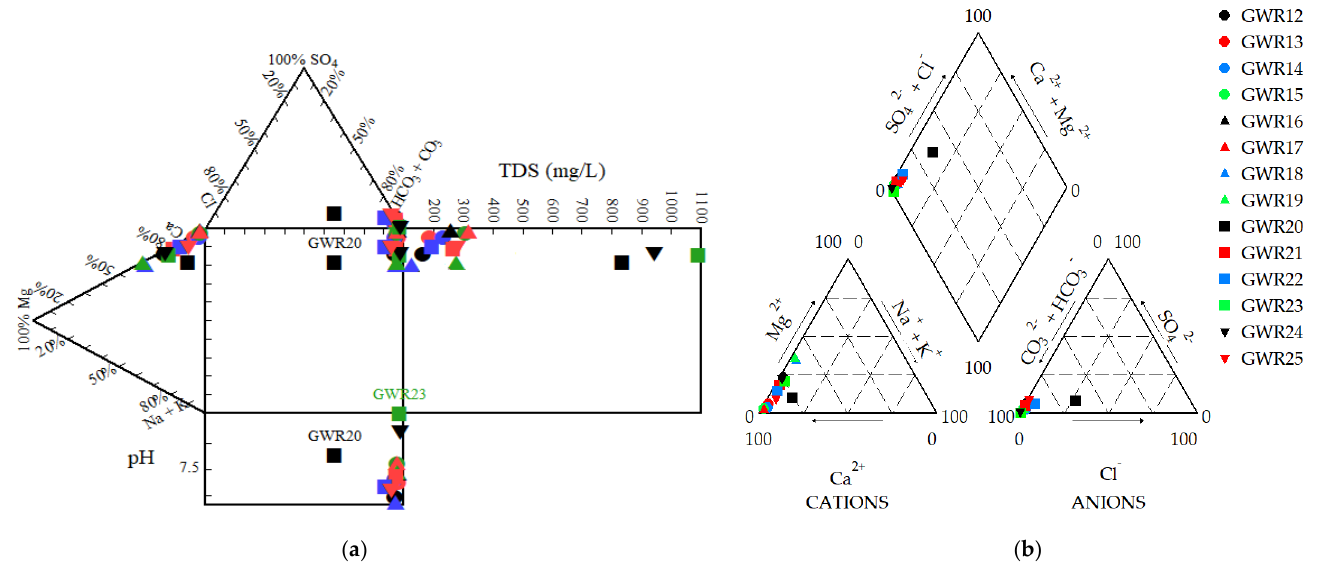
Figure 2. Durov ( a ) and Piper ( b ) diagrams describing the water facies of the studied karst waters.